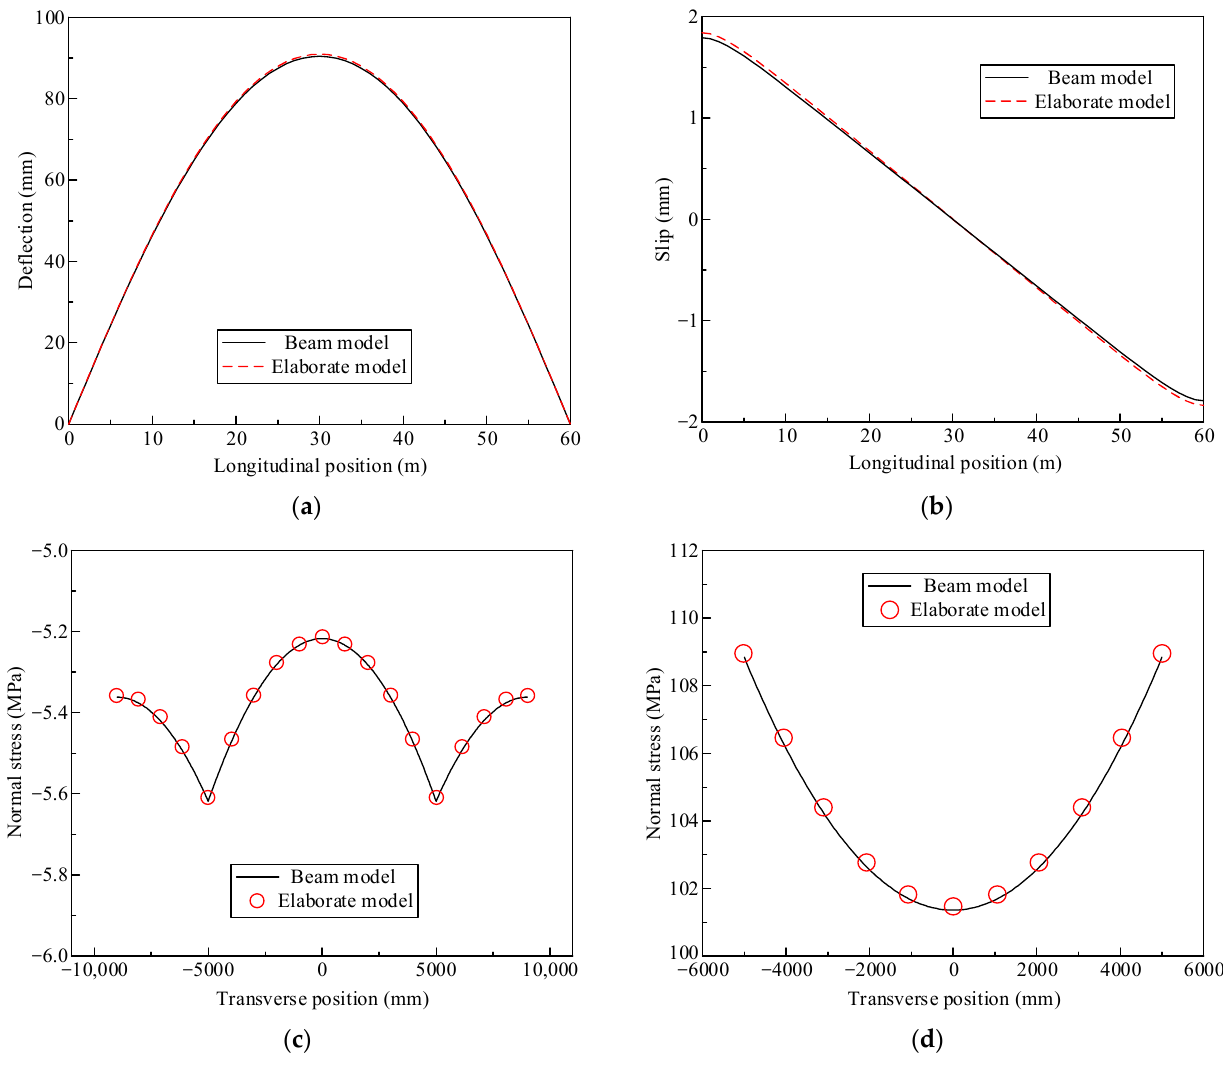
Figure 6. Comparison of prediction results from the finite beam element and finite elaborate element models for a simply supported composite bridge. ( a ) Deflection; ( b ) Interface slip; ( c ) Normal stress of concrete slab at mid-span section; ( d ) Normal stress of steel flange at mid-span section.